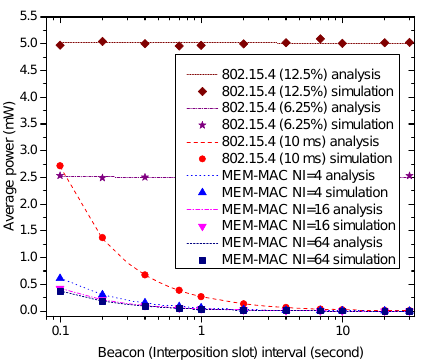
Figure 9. The effects of the beacon frame interval and interposition interval on coordinator average power.